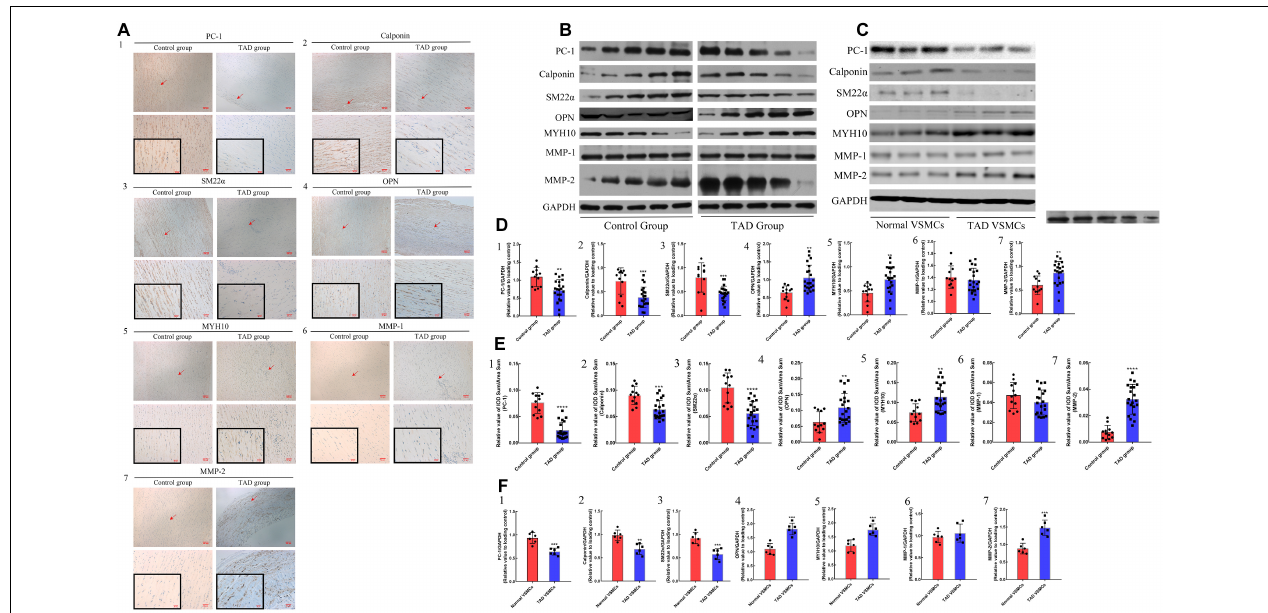
FIGURE 1 | IHC results and protein expression in control ( n = 12) and TAD group ( n = 21) and in vitro studies between normal ( n = 6) and TAD VSMCs ( n = 6). Decreased positive area of (A1,E1) PC-1 ( p < 0.0001), (A2,E2) calponin ( p = 0.0002) and (A3,E3) SM22 α ( p < 0.0001) as well as increased positive area of, (A4,E4) OPN ( p = 0.0049), (A5,E5) MYH10 ( p = 0.0011) and (A7,E7) MMP-2 ( p < 0.0001) in the TAD group. The positive area of (A6,E6) MMP-1 showed no significance between two groups. Increased expression of (B,D4) OPN ( p = 0.001), (B,D5) MYH10 ( p = 0.0029), (B,D7) MMP-2 ( p = 0.0034) as well as decreased expression of (B,D1 ) PC-1 ( p = 0.0011), (B,D2) calponin ( p = 0.0004) and (B,D3) SM22 α ( p = 0.0002) in TAD group. The expression of (A) MMP-1 were not significant between two groups. TAD VSMCs exhibited lower expression of (C,F1–3) PC-1 ( p = 0.0004), calponin ( p = 0.001) and SM22 α ( p = 0.0005) as well as higher expression of (C,F4,5,7) OPN ( p = 0.0001), MYH10 ( p = 0.0008), MMP-2 ( p = 0.0003), but the (C,F6) MMP-1 were not significantly different between these groups. ** p < 0.01, *** p < 0.001, **** p <